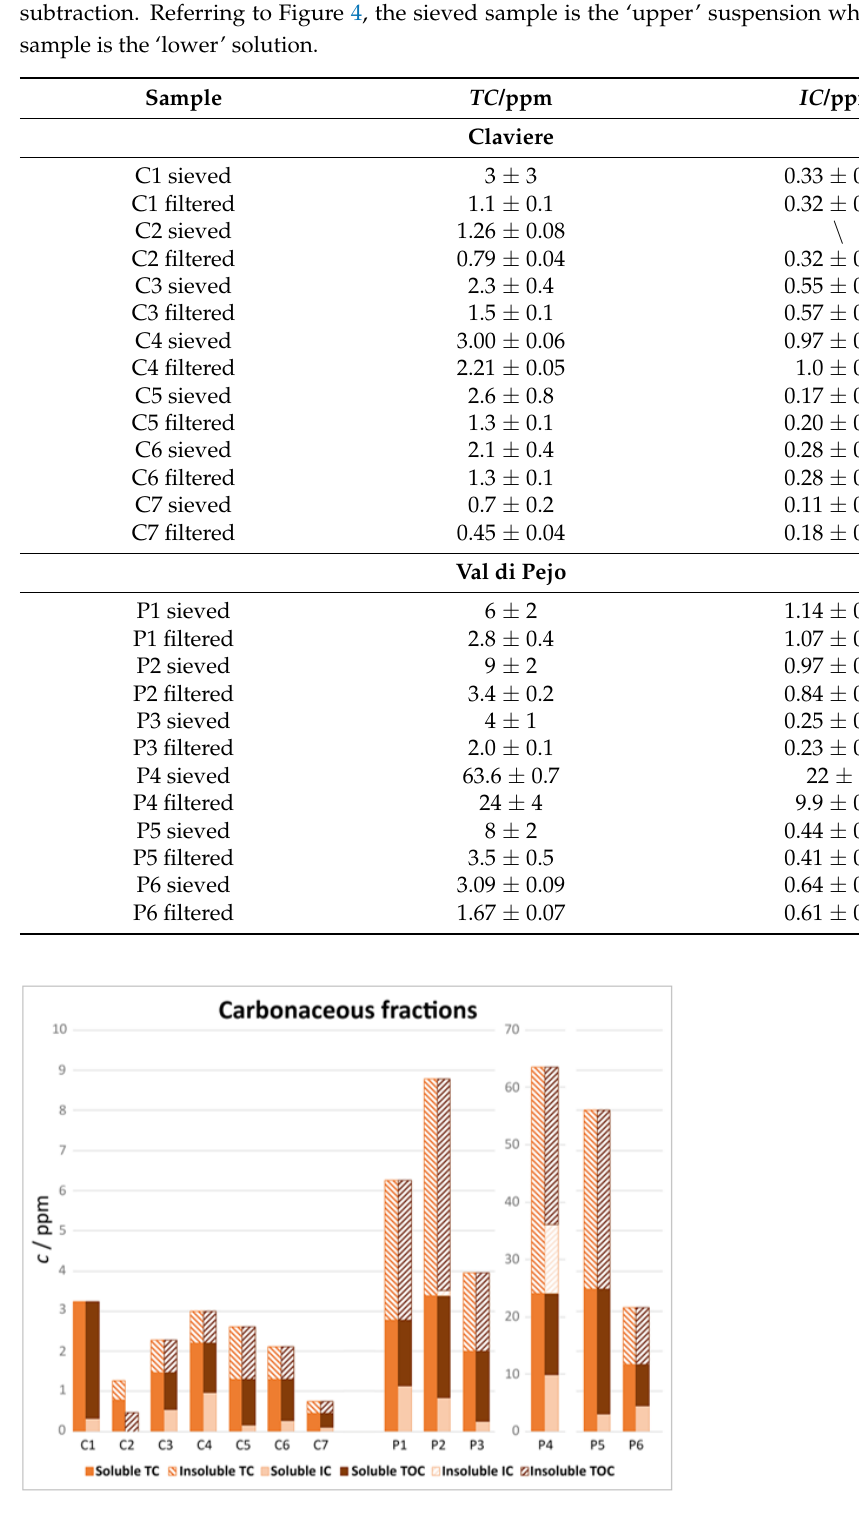
Figure 7. Separation of the soluble (filtered solution, Figure 4) and insoluble (sieved suspension minus filtered solution, Figure 4) TC into their respective components: IC and TOC.